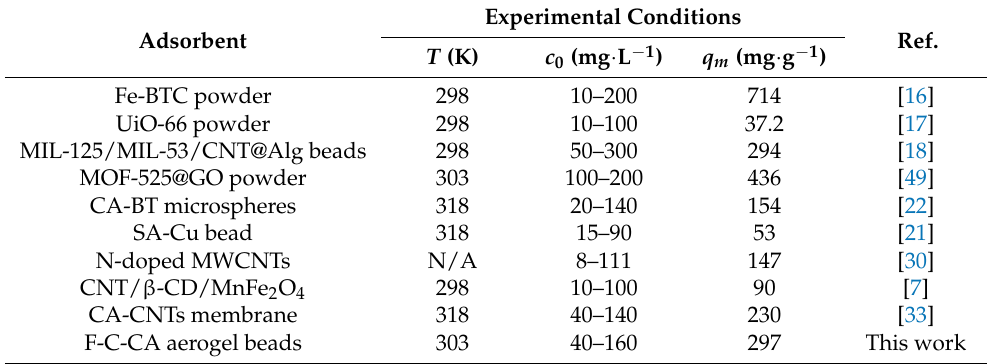
Table 6. The comparison results of adsorption properties of TC on various